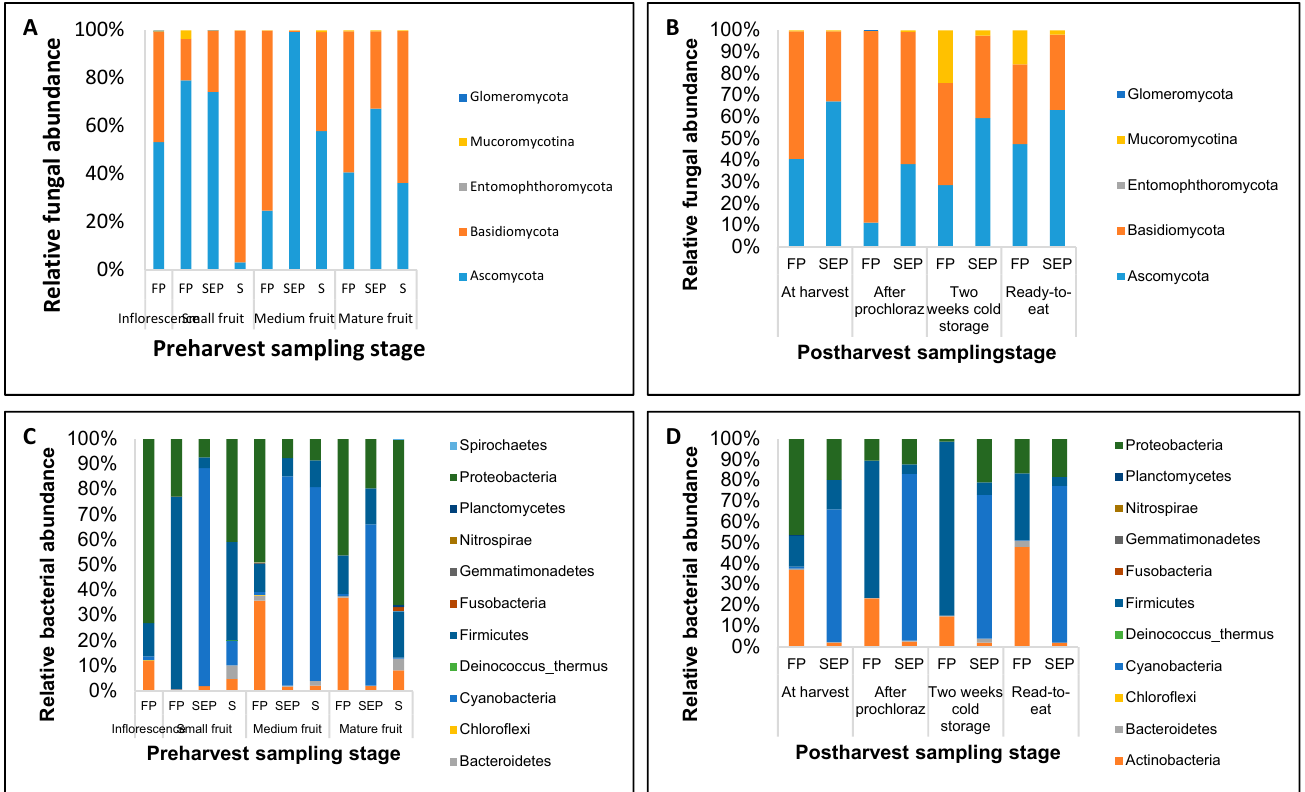
0%20%40%60%80%100% Figure 3. Taxonomic abundance of major fungal phyla on the mango fructoplane, stem-end pulp and fruit stem at the pre-harvest ( A ) and post-harvest ( B ) stages; bacterial phyla at the pre-harvest ( C ) and post-harvest ( D ) stages of cv. Tommy Atkins mangoes. FP, fructoplane; SEP, stem-end pulp; S, fruit stem.